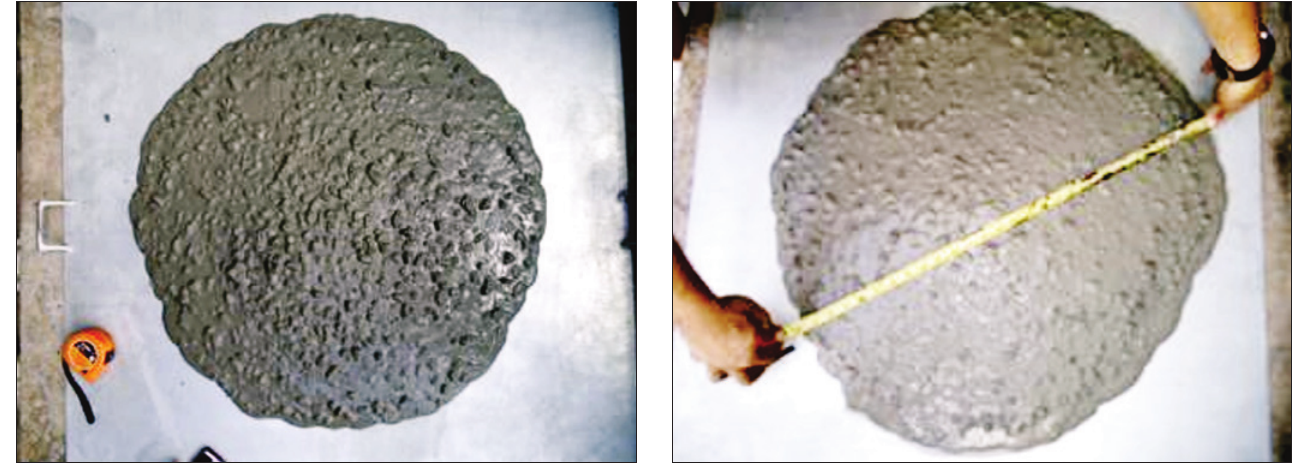
(a) Concrete without SCBA (b) Concrete with 10% of SCBA